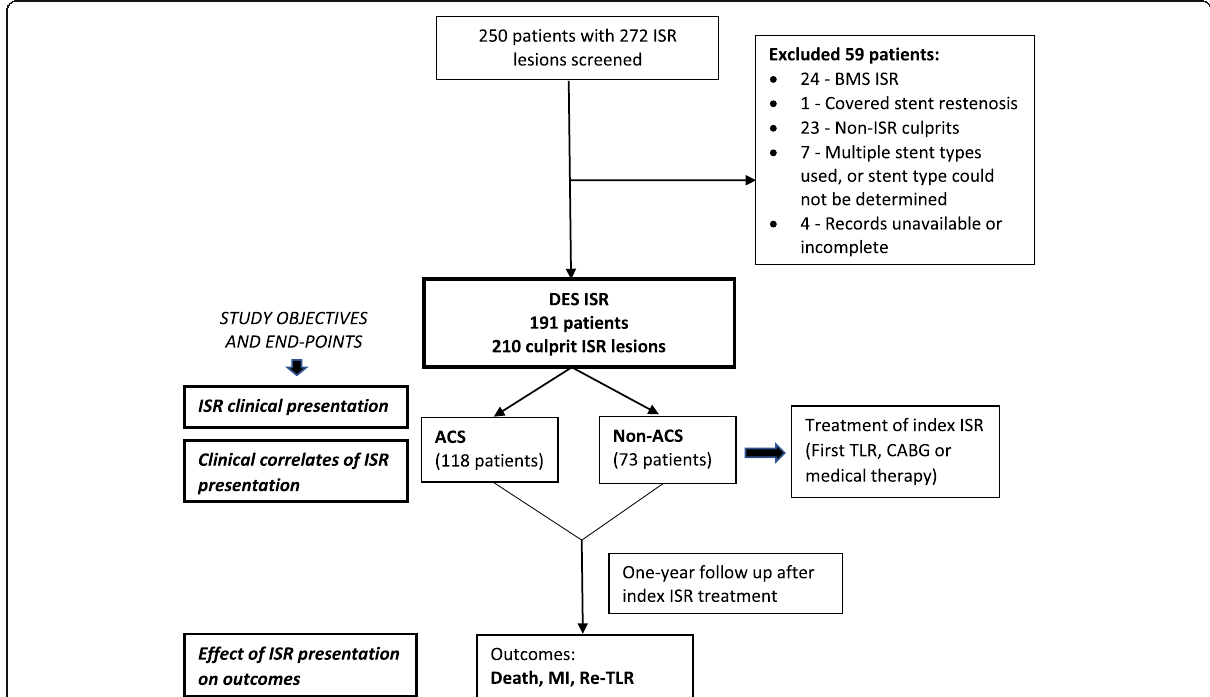
Fig. 1 Study flow chart. ACS: acute coronary syndrome; BMS: bare-metal stent; CABG: coronary artery bypass grafting; DES: drug-eluting stent; ISR: in-stent restenosis, MI: myocardial infarction; TLR: target-lesion